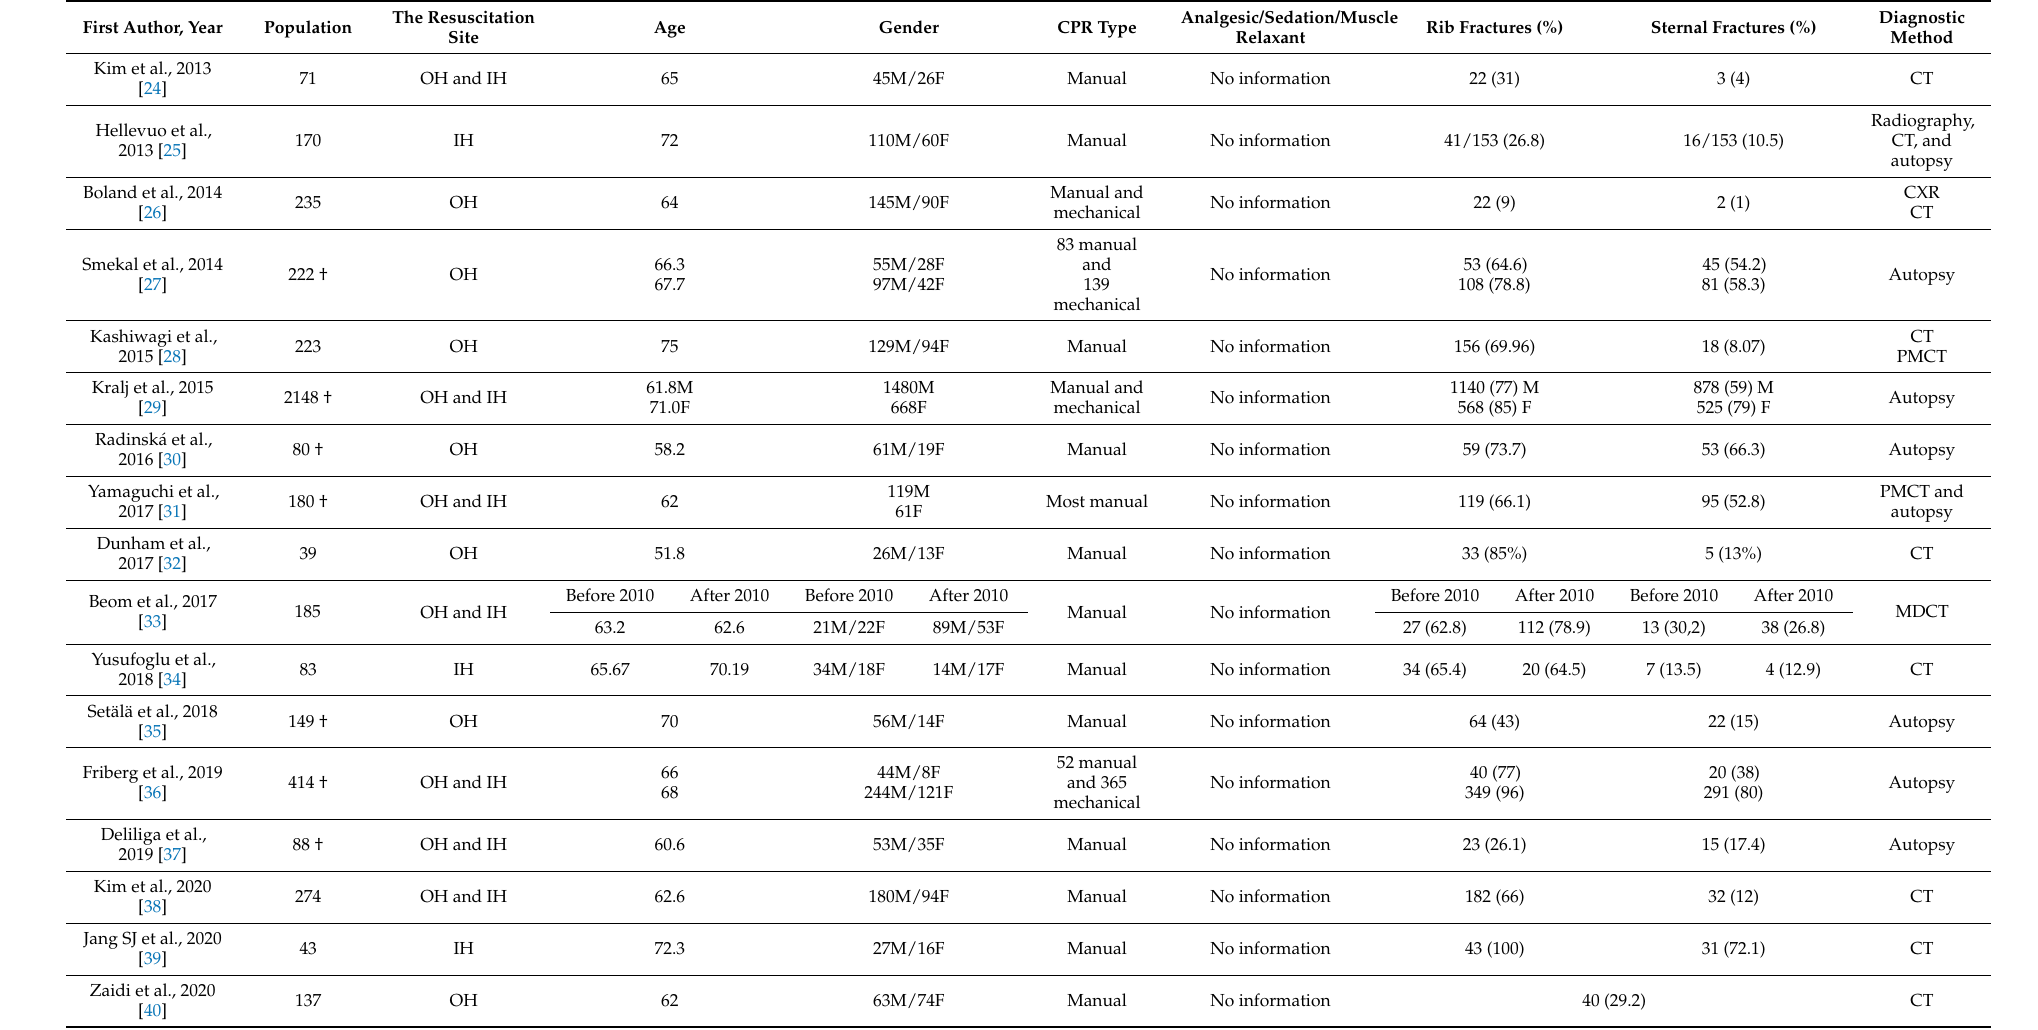
Table 3. Chest injuries during